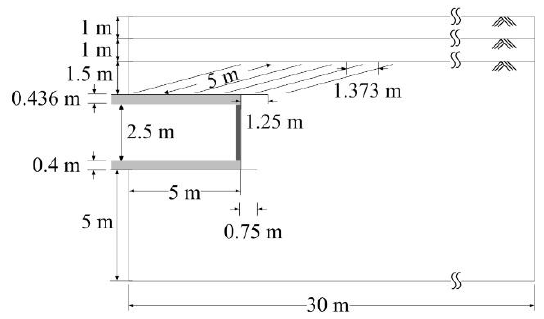
Figure 11. Specification of modeling range.